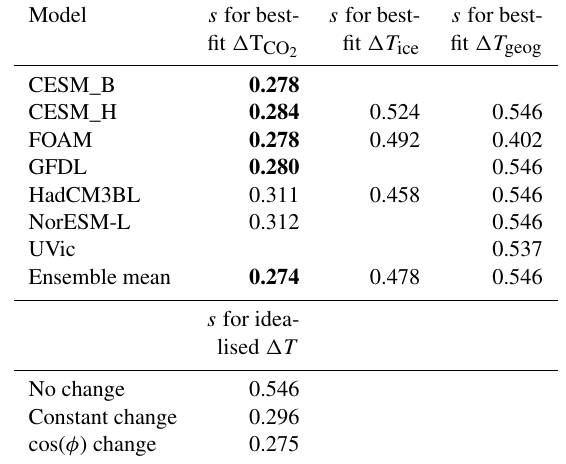
Table 3. Skill scores, s , for the best-fit modelled changes in re- sponse to CO 2 , ice and palaeogeographic forcing, for each model and for the ensemble mean (a lower value of s represents a better fit to data). Also shown are the values of s for three idealised SAT changes. The models all achieve their best skill performance with CO 2 forcing (UVic does not include CO 2 forcing). Four models (CESM_B, CESM_H, FOAM and GFDL) achieve a better skill than an idealised constant temperature change, while the ensemble mean achieves better than the idealised cos( φ ) case. However, the spread in skill across the different models is narrow. Changes highlighted in bold are better than or equal to the idealised constant-change case, while the ensemble mean is better than the cos( φ )